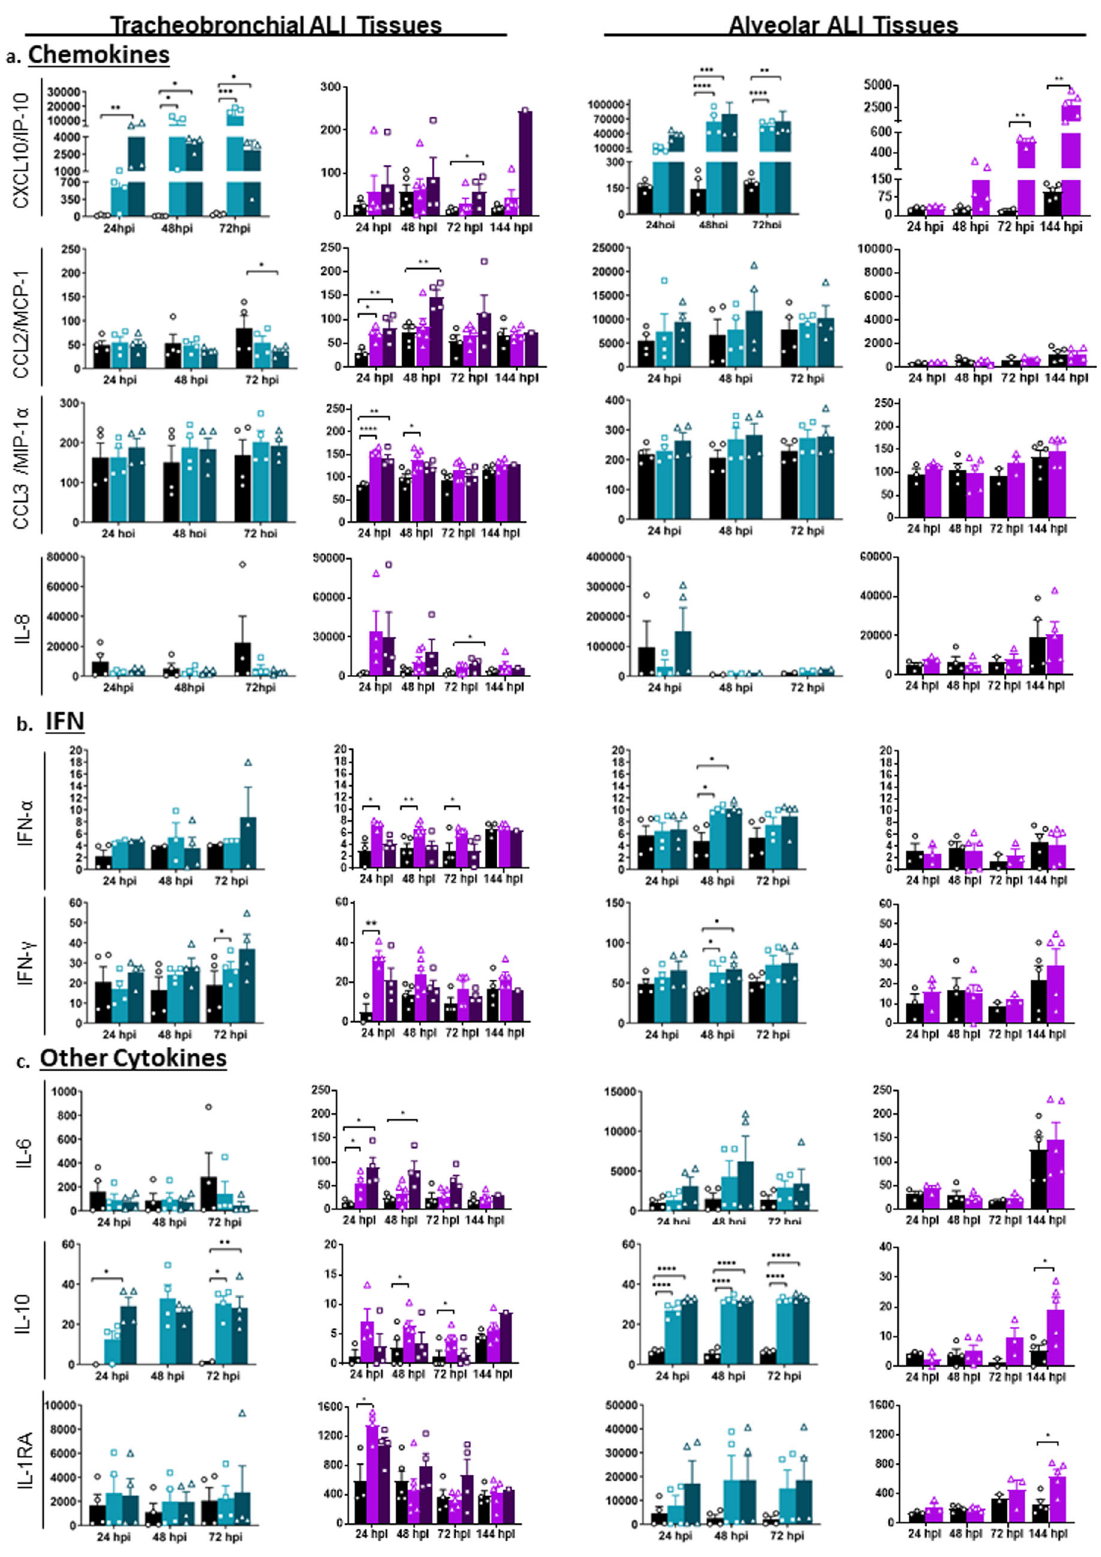
TMPRSS2 inhibitor, and nel fi navir, an anti-retroviral, currently being tested in clinical trials 40,66 – 69 , both reduced SARS-CoV-2 infection in the tracheobronchial ALI tissue (Fig. 8a, c, Supple- mentary Fig. 10a, 10 μ M) and alveolar ALI tissues (Supplemen- tary Fig. 10b, 10 μ